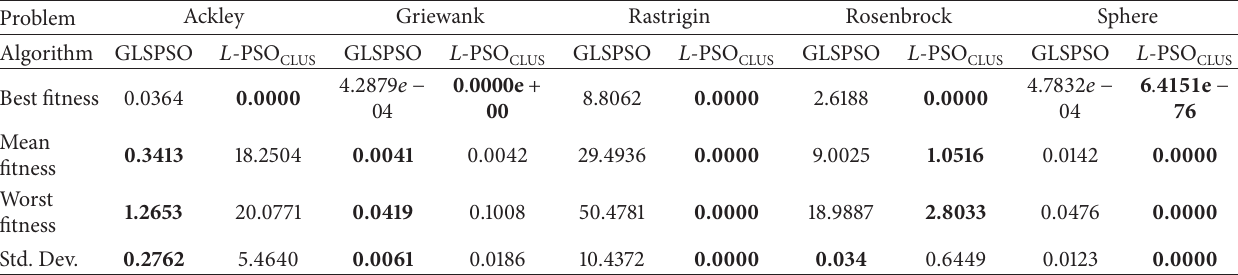
for problems with dimension of 10. CLUS